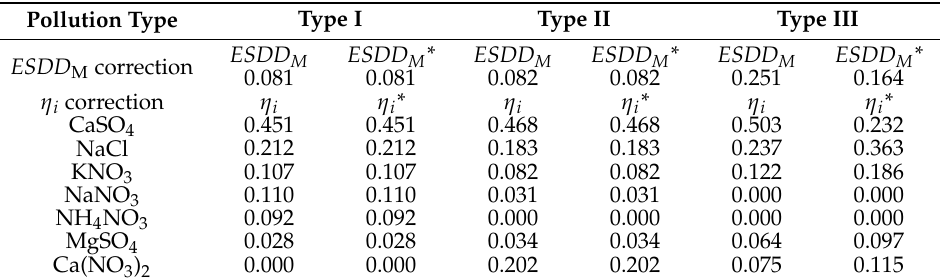
Table 10. Correction of measured equivalent salt deposit density and ESDD percentage of each soluble